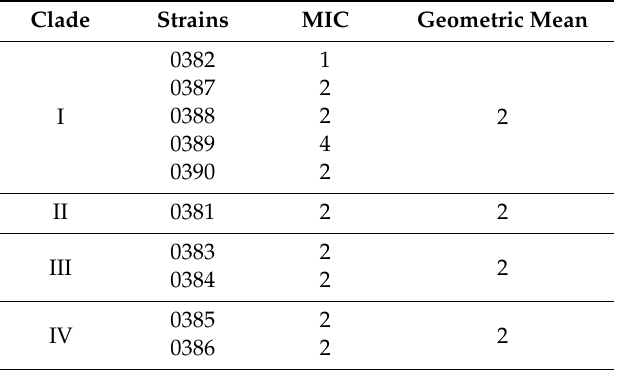
Table 1. Planktonic MIC values ( µ g mL − 1 ) of BiNPs against C. auris strains from the di ff erent clades. Clade Strains MIC Geometric Mean